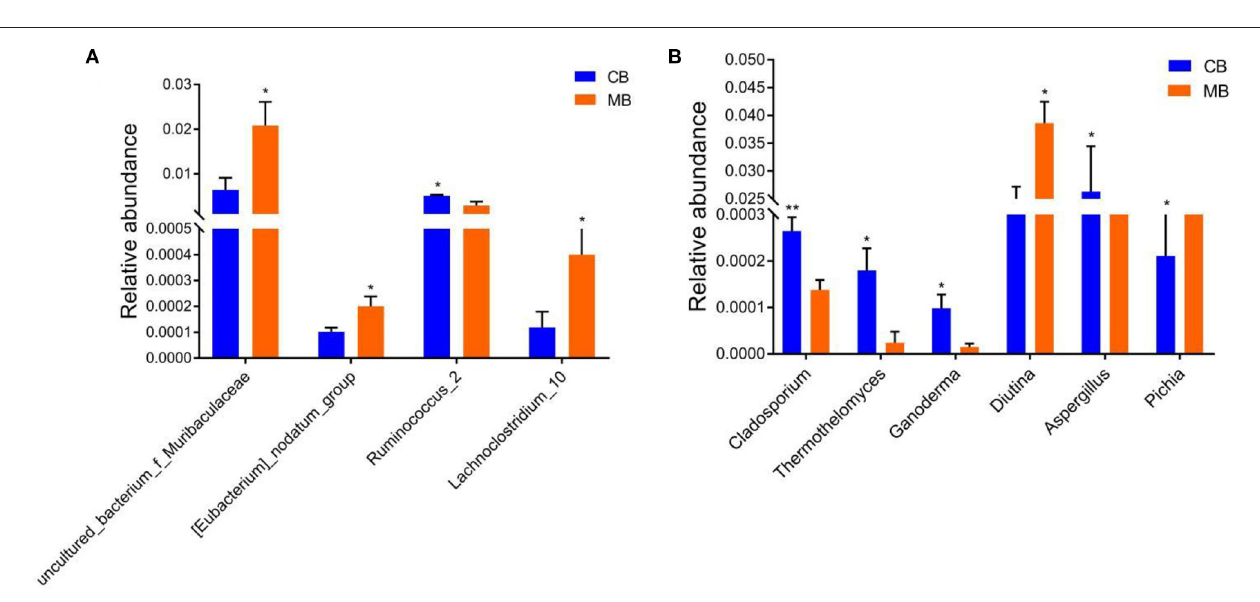
FIGURE 5 | Significant changes in the intestinal bacteria (A) and fungi (B) associated with mastitis in buffalos. Data was indicated as mean ± SD. * p < 0.05, ** p <